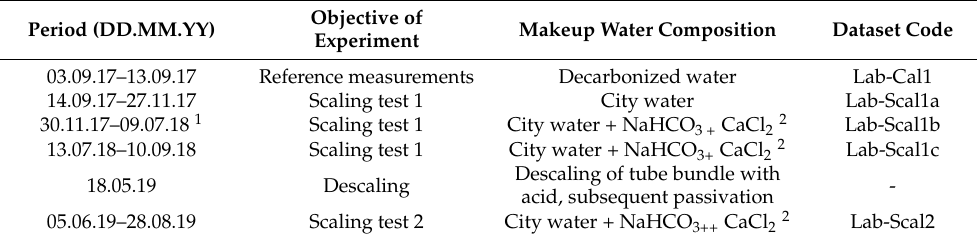
Table 3. Overview on executed lab